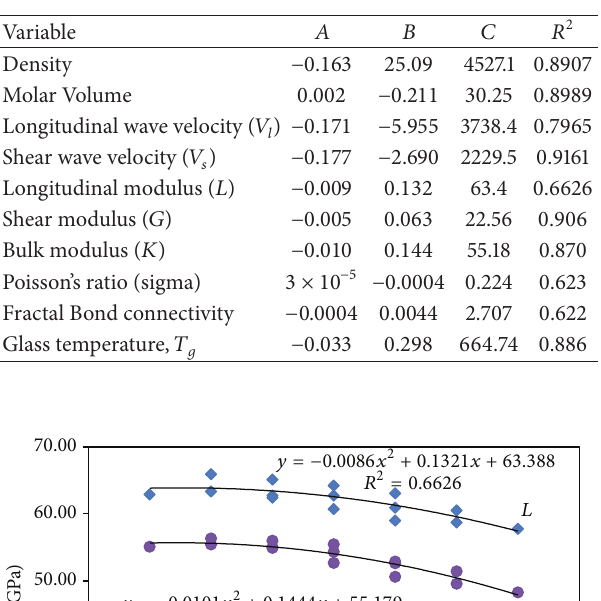
Table 5: Nonlinear regression analysis of the variables ( 𝑦 = 𝐴𝑥 2 + 𝐵𝑥 + 𝐶 ) for various properties of ZOFT glass series.